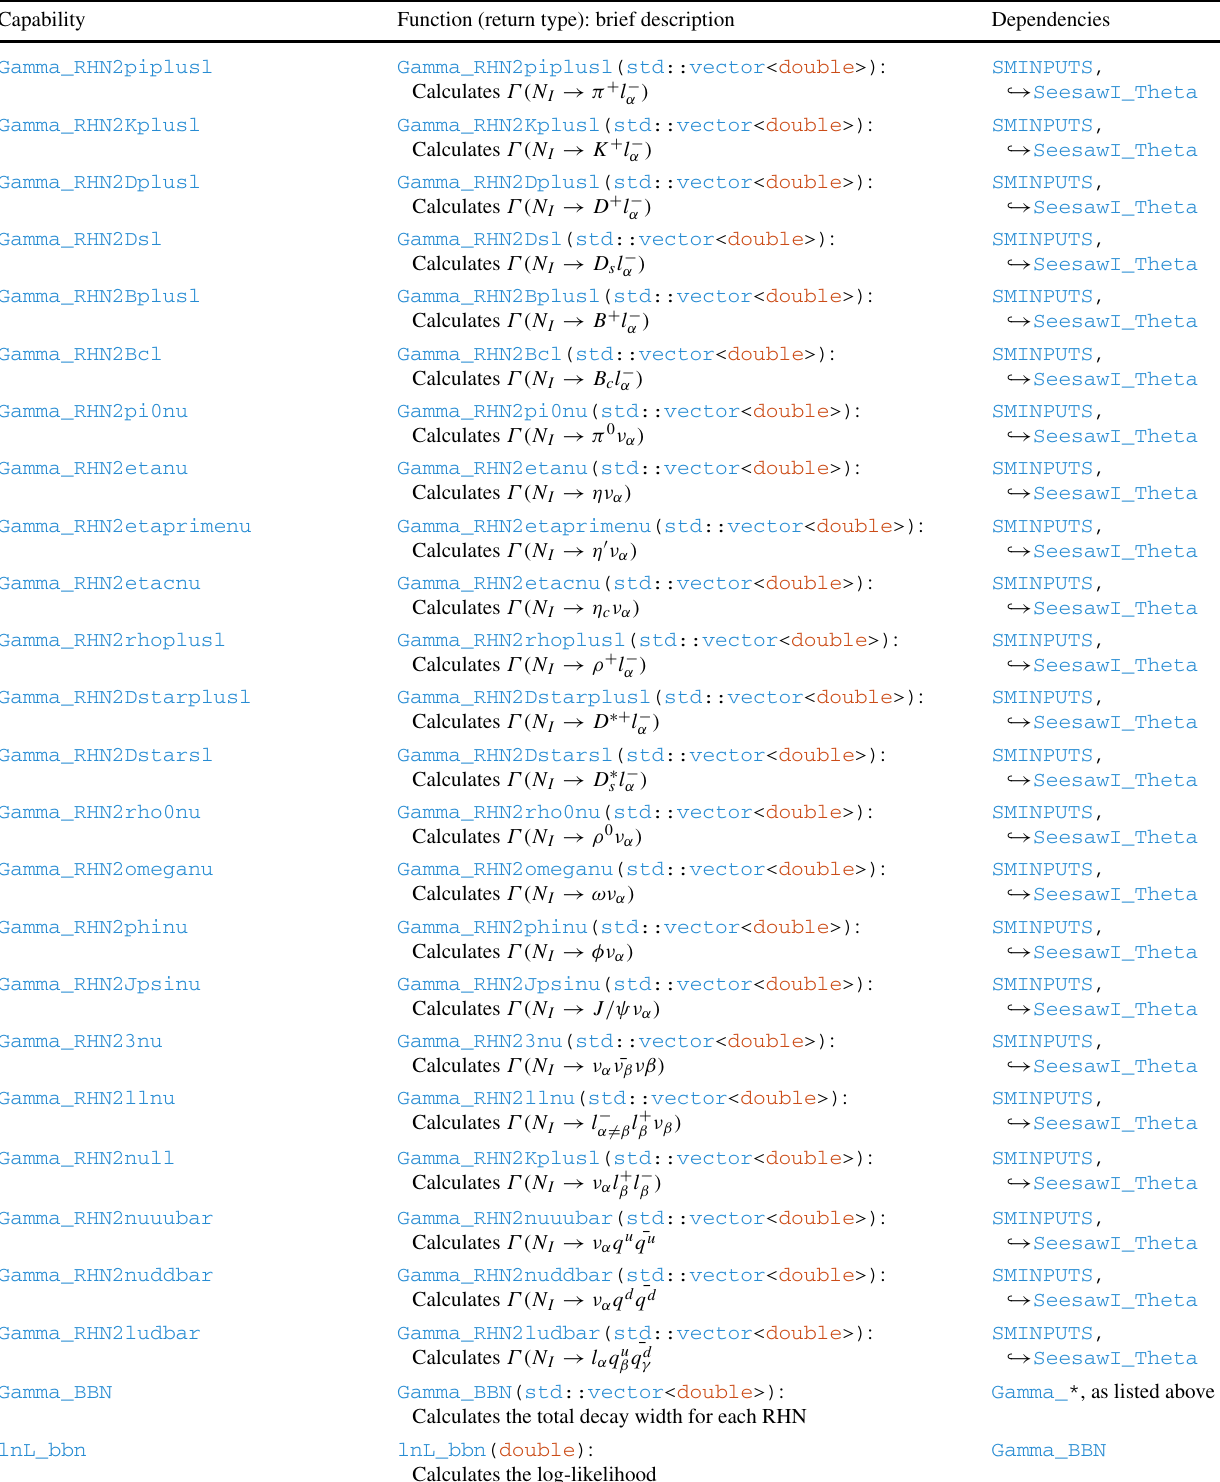
Table 17 Capabilities and module functions implemented in NeutrinoBit to calculate BBN observables and likelihood for sterile neutrino models